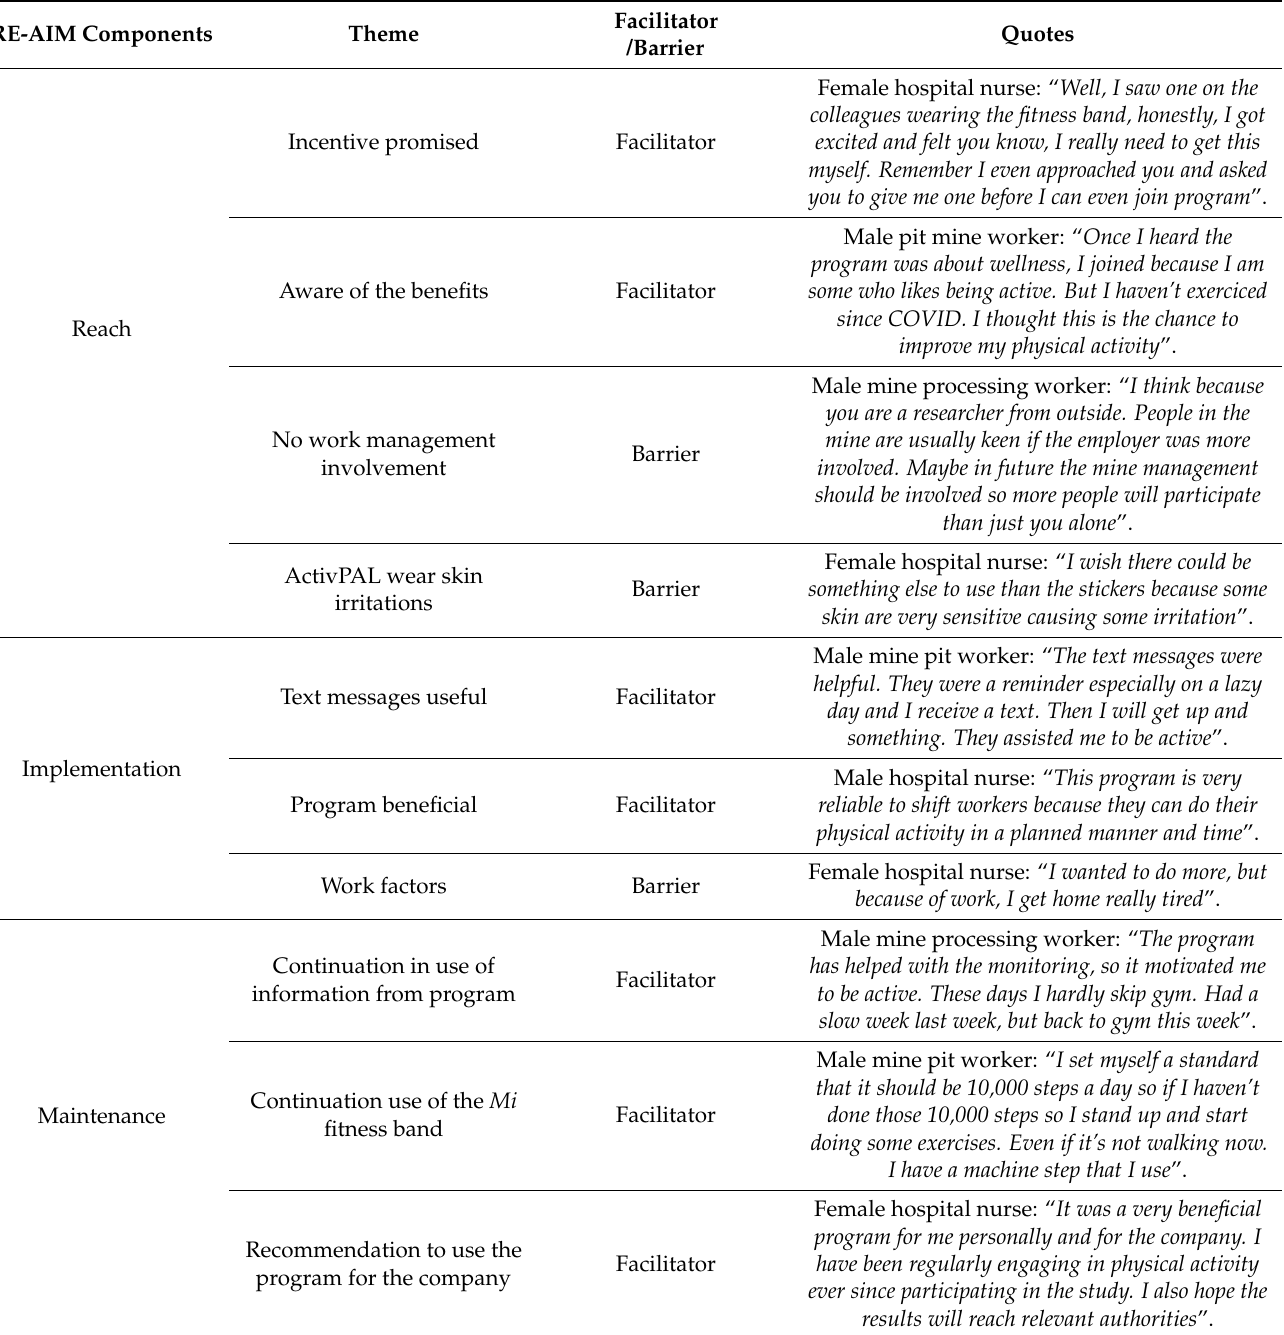
Table 4. Themes related to indicators of reach, adoption, implementation and